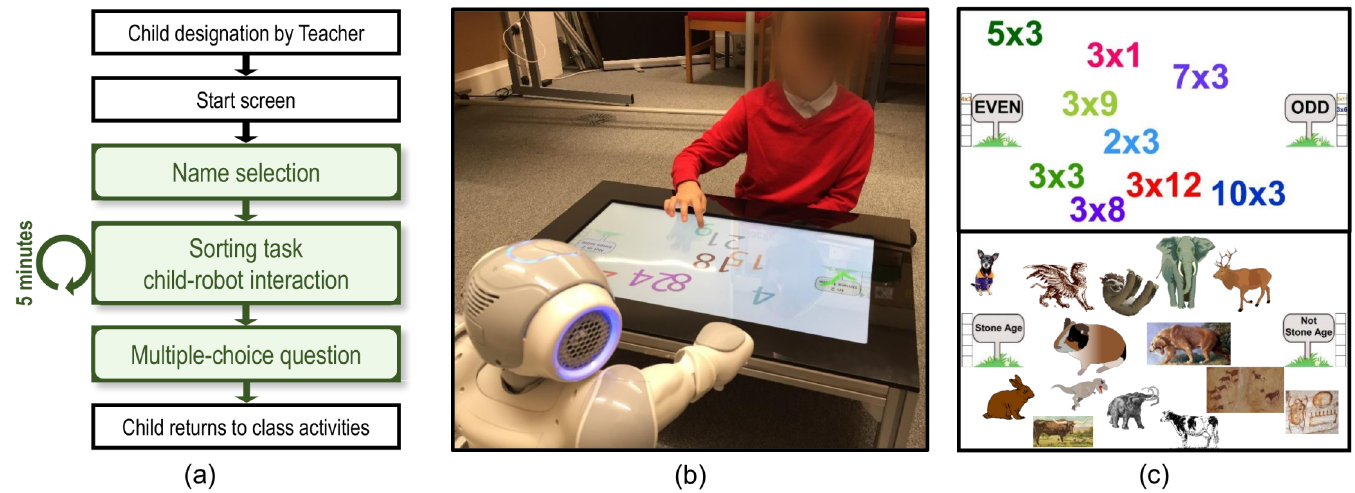
Fig 2. Interaction structure and contents. (a) structure of each interaction, with five minutes on the collaborativesorting task itself; (b) exampleof a child engagedin the task with the robot (hardware and classroom setup as shown in Fig 1); (c) two sample image libraries,showinga 3 times-tabletask, and a stone-age animals